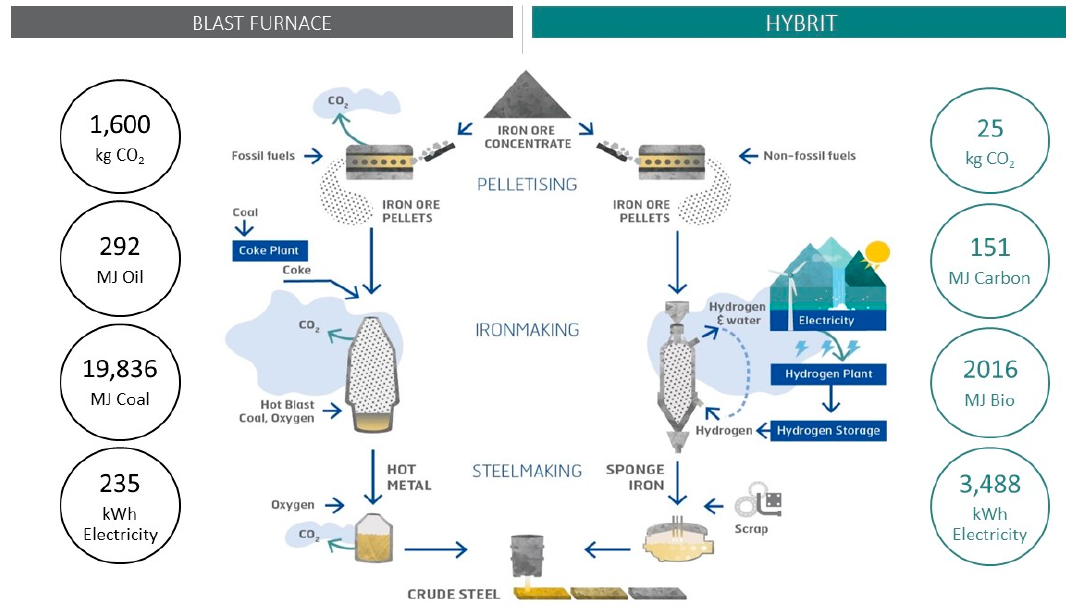
Figure 7. Comparison of some emission and consumption figures for the SSAB blast furnace route and the HYBRIT concept, data from [24].